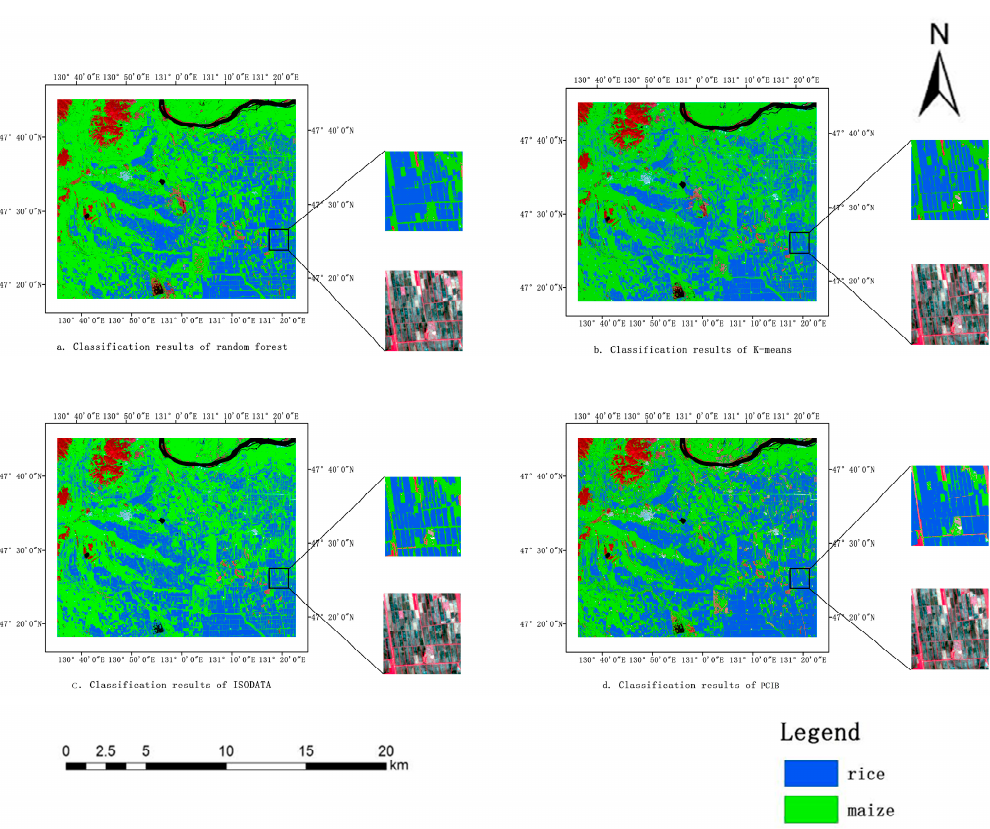
Figure 8. Classification mapping results for Luobei County in 2016.